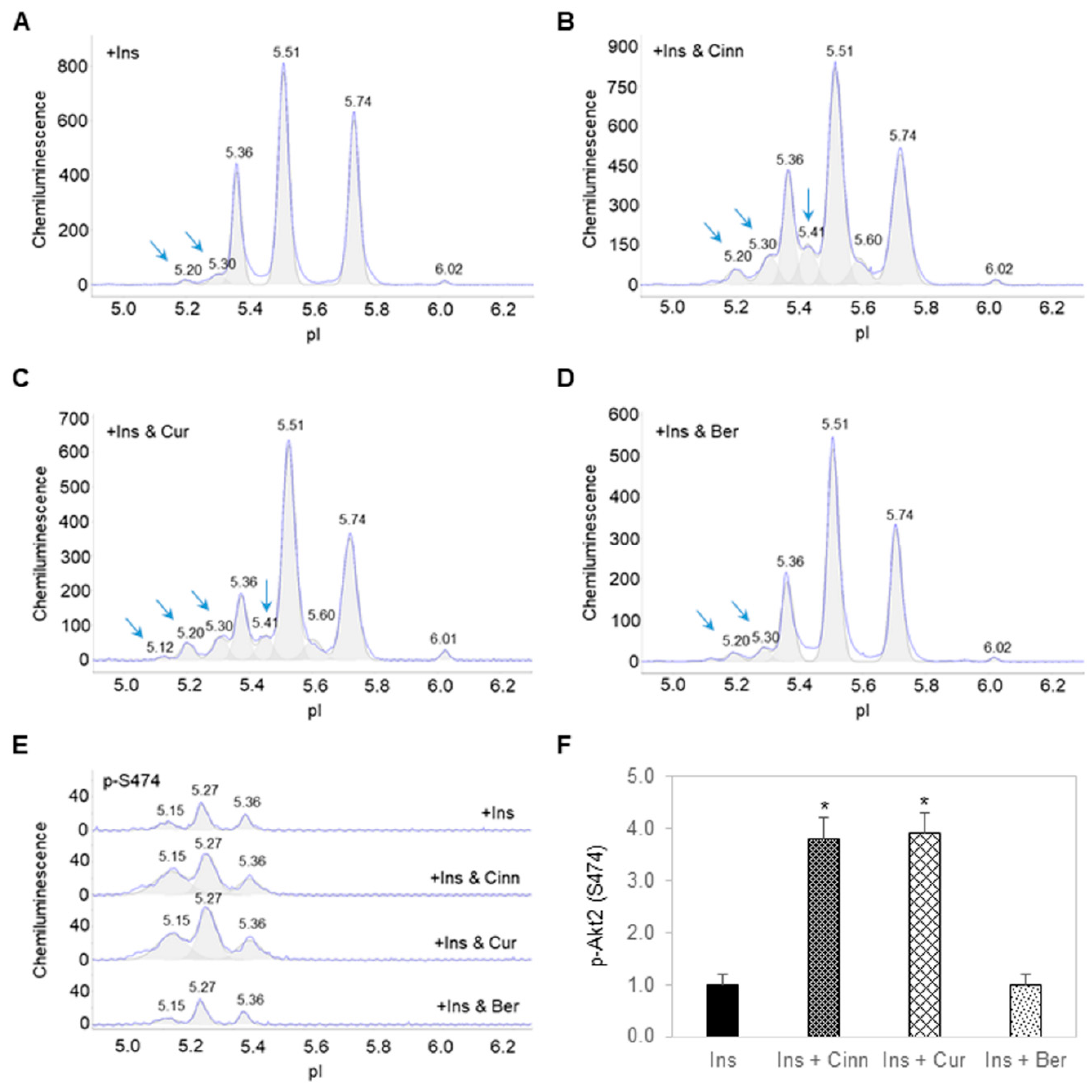
Figure 2. Cinnamaldehyde and curcumin enhance insulin-stimulated activation of Akt2. ( A – D ) Distribution of Akt2 as a function of isoelectric points in preadipocytes treated with ( A ) insulin alone, ( B ) insulin and cinnamaldehyde, ( C ) insulin and curcumin, or ( D ) insulin and berberine. ( E ) Distribu- tion of p-Akt2 (S474) as a function of isoelectric points in preadipocytes treated with insulin alone (top electropherogram), insulin and cinnamaldehyde (second electropherogram), insulin and curcumin (third electropherogram), or insulin and berberine (bottom electropherogram). ( F ) Relative abundance of p-Akt2 (S474) as a function of treatment condition. Error bars are standard deviations across nine repeated measurements. Asterisk indicates p -value ≤ 0.01 versus treatment with insulin